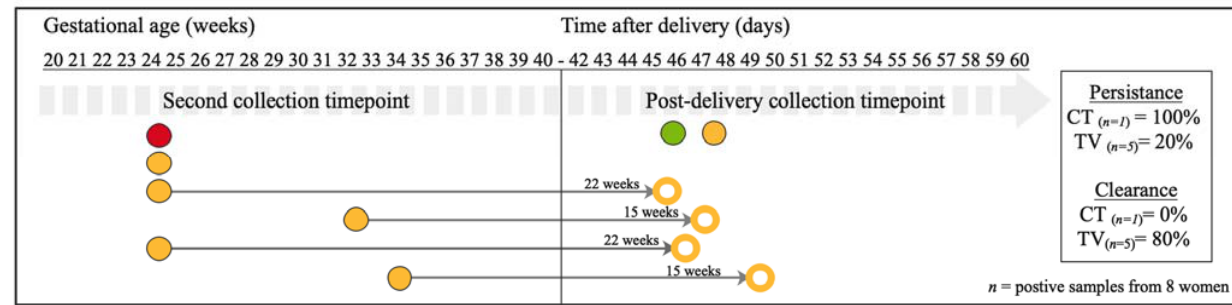
Figure 3. Schematic overview of the persistence and clearance of CT, NG, TV and MG genital infections of positive vaginal swabs collected during pregnancy and post-delivery ( n = 8 infected women out of 38 tested women). Horizontal labels indicate the time of collection in gestational age in weeks. Each dot represents a vaginal sample positive for C. trachomatis (in red), T. vaginalis (in yellow), N. gonorrhoeae (in green), and M. genitalium (in blue). M. genitalium was not detected at the second timepoint in this sub-cohort. Open dots represent cleared infections. The thin grey arrows, with the interval between testing in weeks on top, connect a positive sample with a matching coloured open dot and it refers to cleared infections. The two dots ( T. vaginalis ( n = 1) and N. gonorrhoeae ( n = 1)) in the post-delivery collection timepoint period indicate samples with de novo infections (as samples from the same women collected at the second timepoint were not positive for the same pathogens). All infections detected at second timepoint did persist if no thin grey arrow was connected to them.